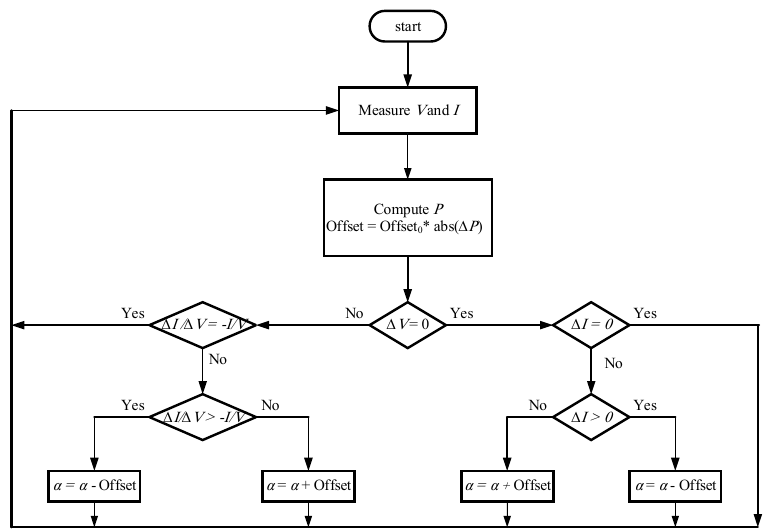
Figure 4. Flowchart of Modified INC algorithm.